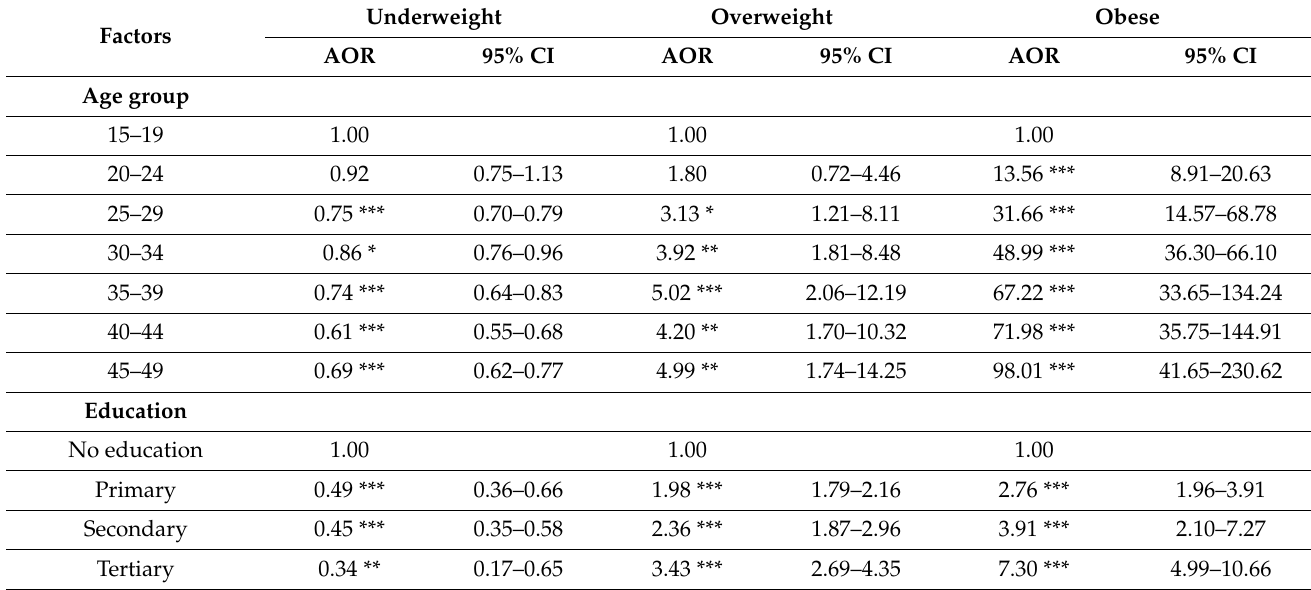
Table 3. Bivariate analysis showing adjusted odds ratio of body weights and associated factors among women of childbearing age by urban–rural variations in